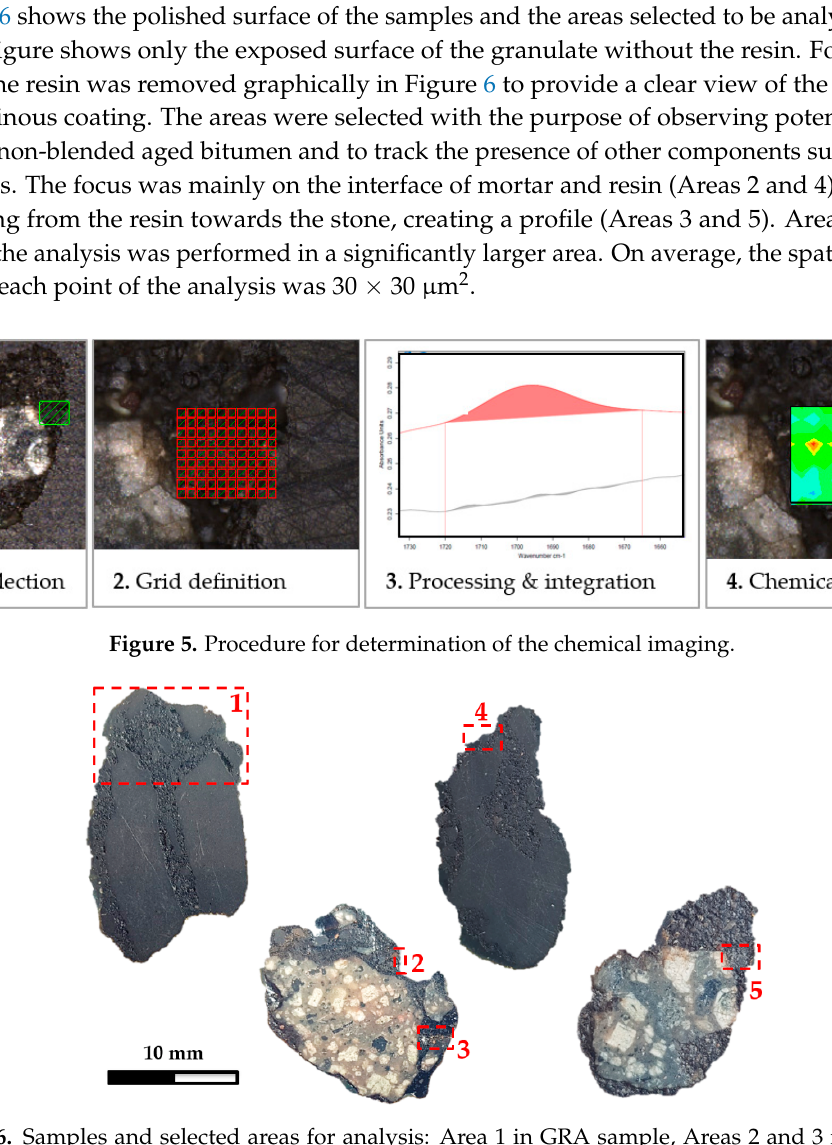
Figure 6. Samples and selected areas for analysis: Area 1 in GRA sample, Areas 2 and 3 in GRAB sample, Area 4 in MRAB sample, and Area 5 in GRAR sample.